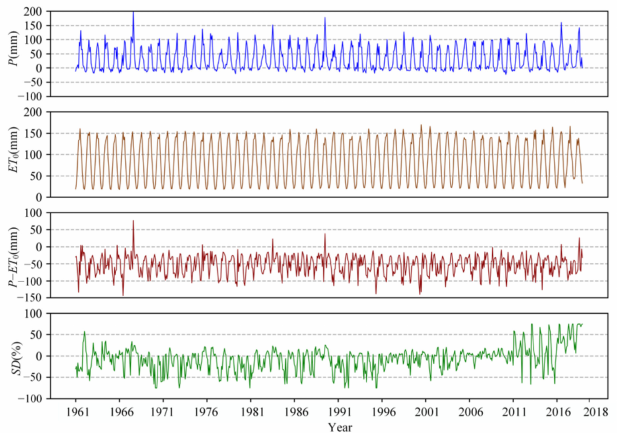
Figure 3. Variations of monthly P , ET 0 , P − ET 0 and soil moisture over 1961–2018 at Gonghe site.